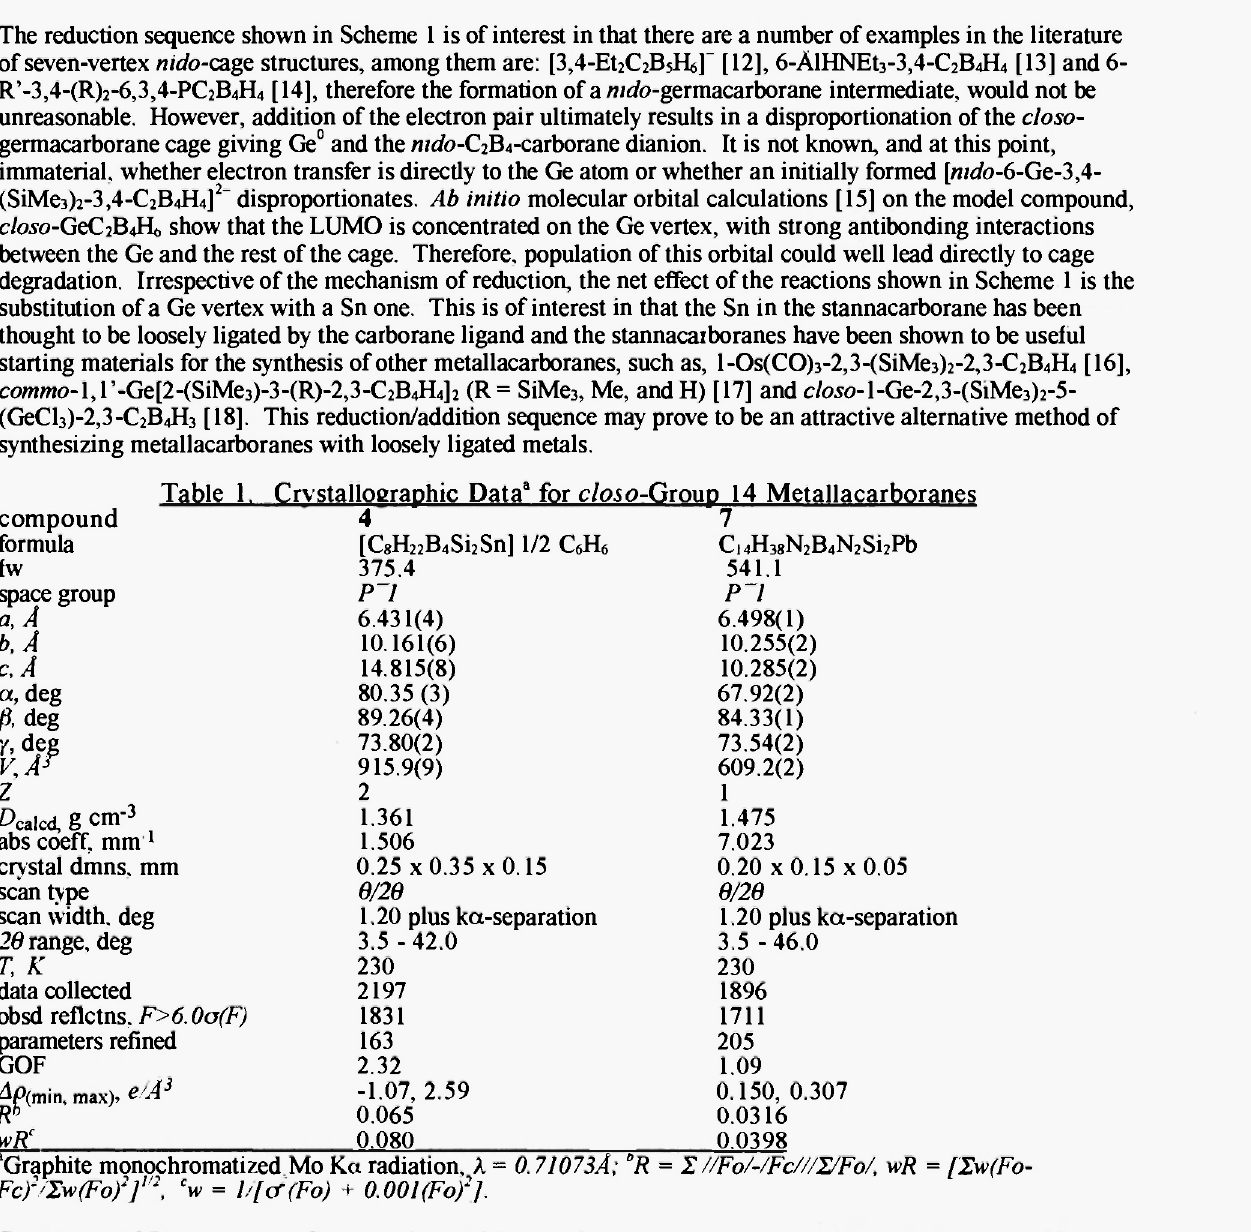
Table 1. Crv stalloeraphic Data 3 for c/o-so-Group 14 Metallacarboranes